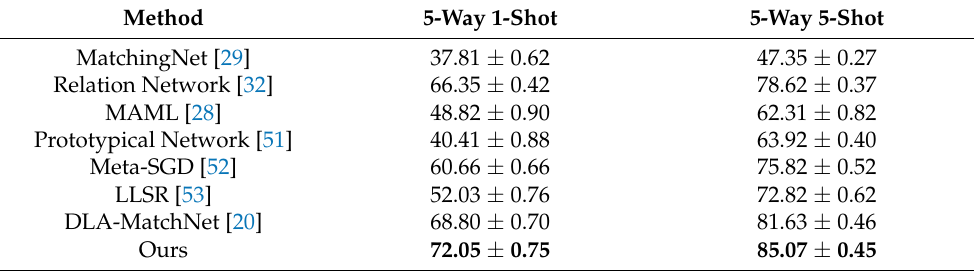
Table 2. Classification accuracy of 5-way 1-shot and 5-way 5-shot on the NWPU-RESISC45